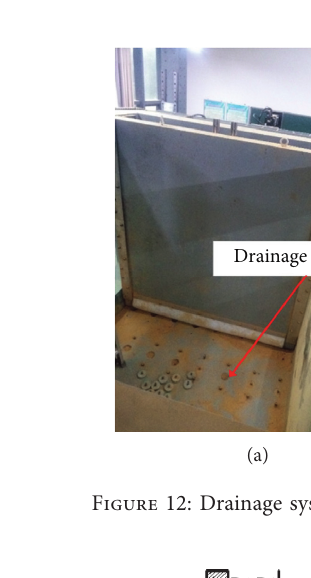
Figure 11: Schematic diagram of testing chamber.